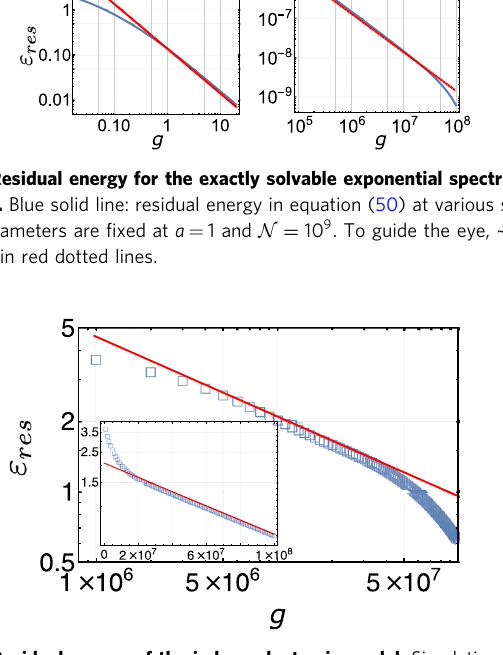
Fig. 8 Residual energy of the independent spin model. Simulation of the residual energy for the independent spin model, plotted in log – log scale. The red solid line is fi tted to 1/ g 0.34 . The total number of spins is 30, which corresponds to N (cid:5) 10 9 . Inset is the same plot in semi-log scale, which shows an exponential fi t of the adiabatic tail (red solid